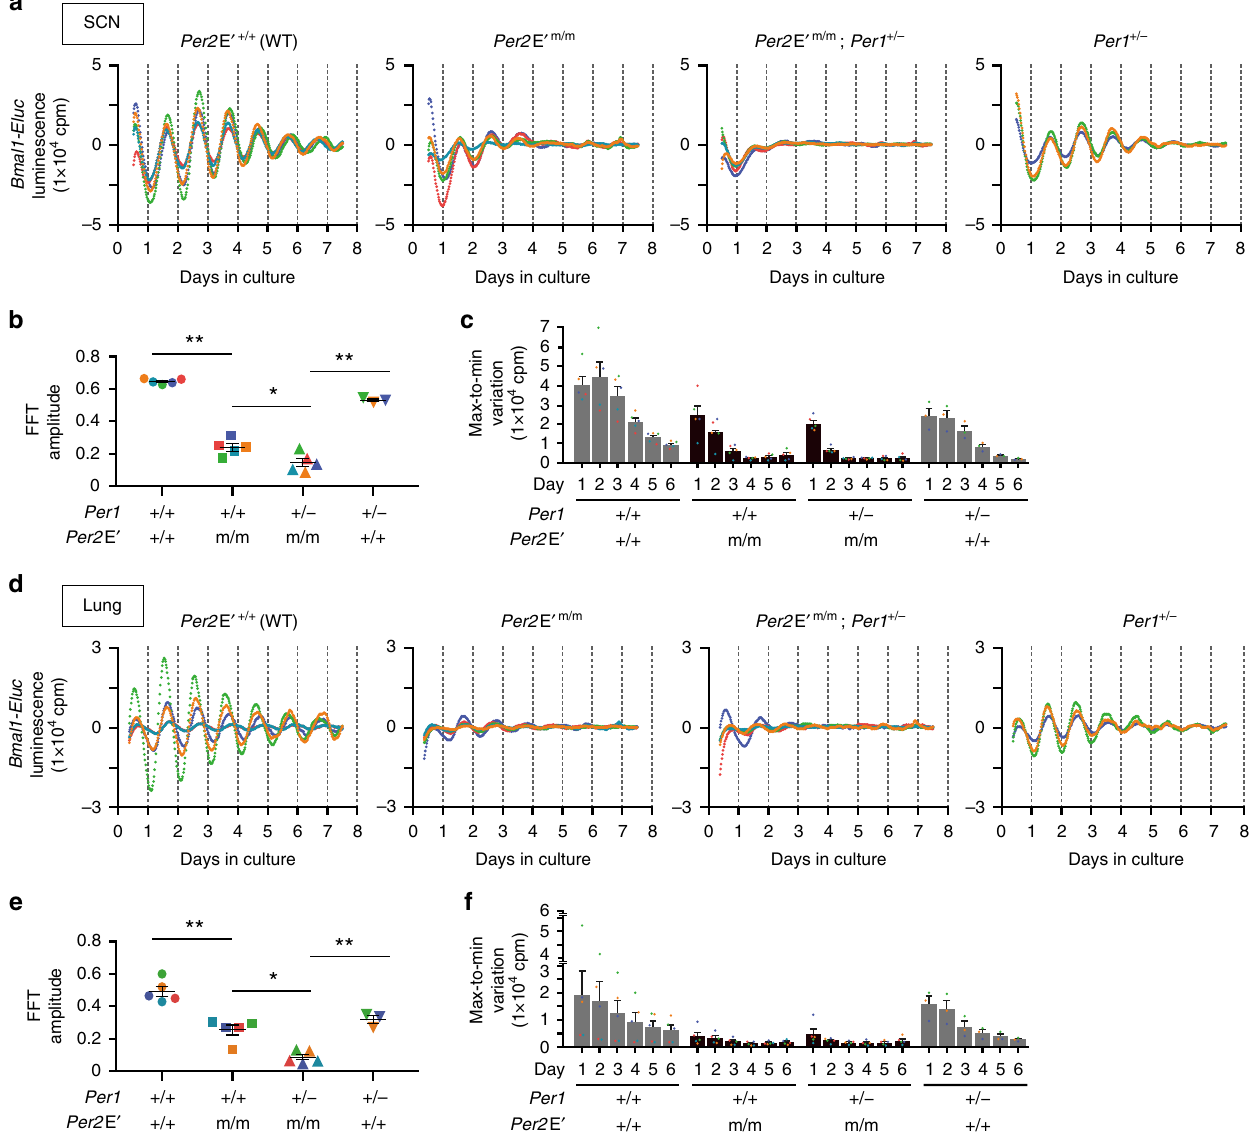
Fig. 3 Per2 E ′ -box is essential for sustainable Bmal1 oscillations in SCN and lung explants. a Bmal1-Eluc bioluminescence traces of ex vivo SCN cultures from Per2 E ′ + / + ( n = 5), Per2 E ′ m/m ( n = 5), Per2 E ′ m/m ; Per1 + / − ( n = 5), and Per1 + / − ( n = 3) mice. Averaged de-trended data are shown. b FFT amplitude of ( a ). * P < 0.05, ** P < 0.001, one-way ANOVA, Bonferroni post hoc test. c Daily max-to-min variations of ( a ). The data are presented as the mean ± s.e.m. d Bmal1-Eluc bioluminescence traces of lung tissue explant cultures from Per2 E ′ + / + ( n = 5), Per2 E ′ m/m ( n = 5), Per2 E ′ m/m ; Per1 + / − ( n = 5), and Per1 + / − ( n = 3) mice. Averaged de-trended data are shown. e FFT amplitude of ( d ). * P < 0.05, ** P < 0.001, one-way ANOVA, Bonferroni post hoc test. f Daily max- to-min variations of ( d ). The data are presented as the mean ± s.e.m. Source data for ( c ) and ( f ) are provided as a Source Data fi